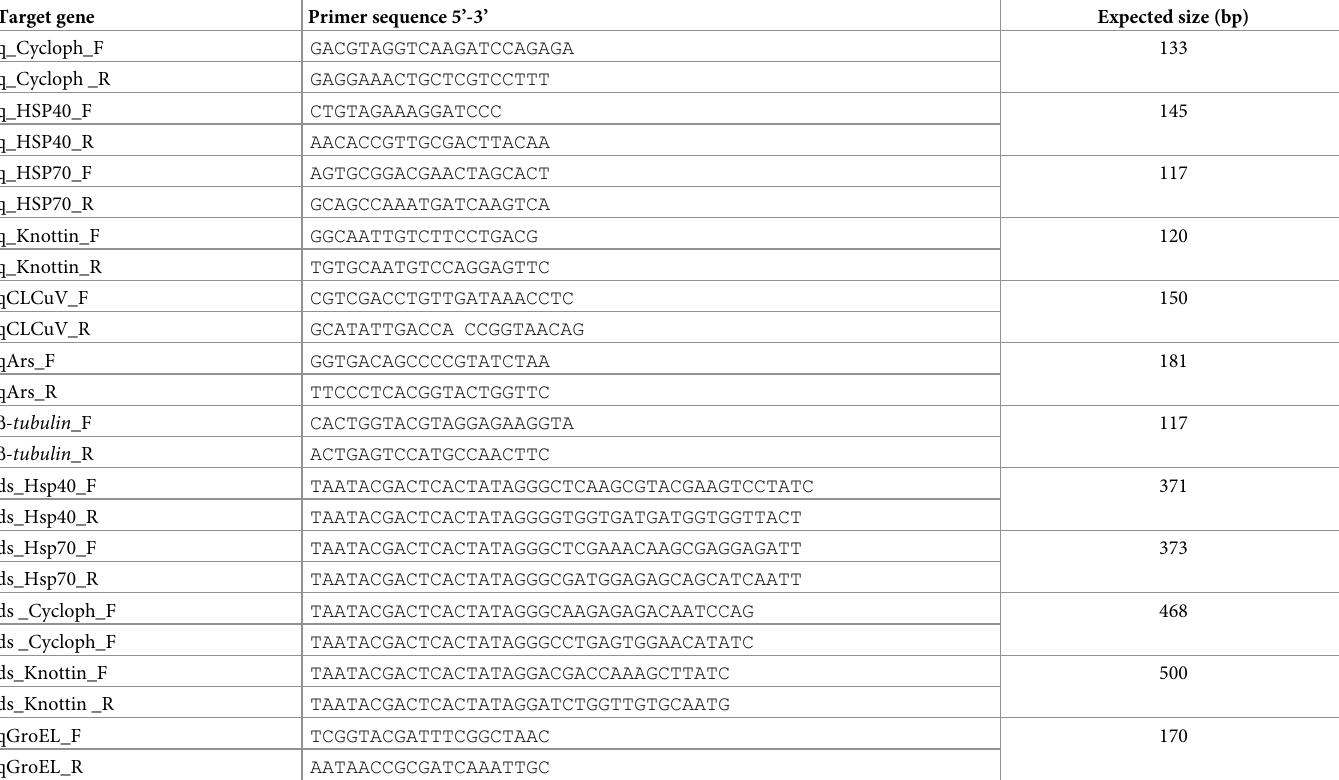
Table 1. Details of primers used in the